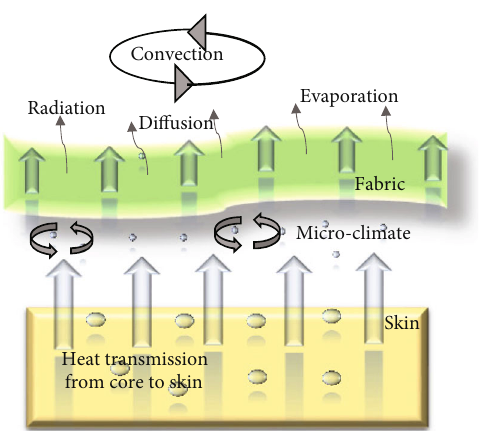
Figure 5: Microclimate between clothing and